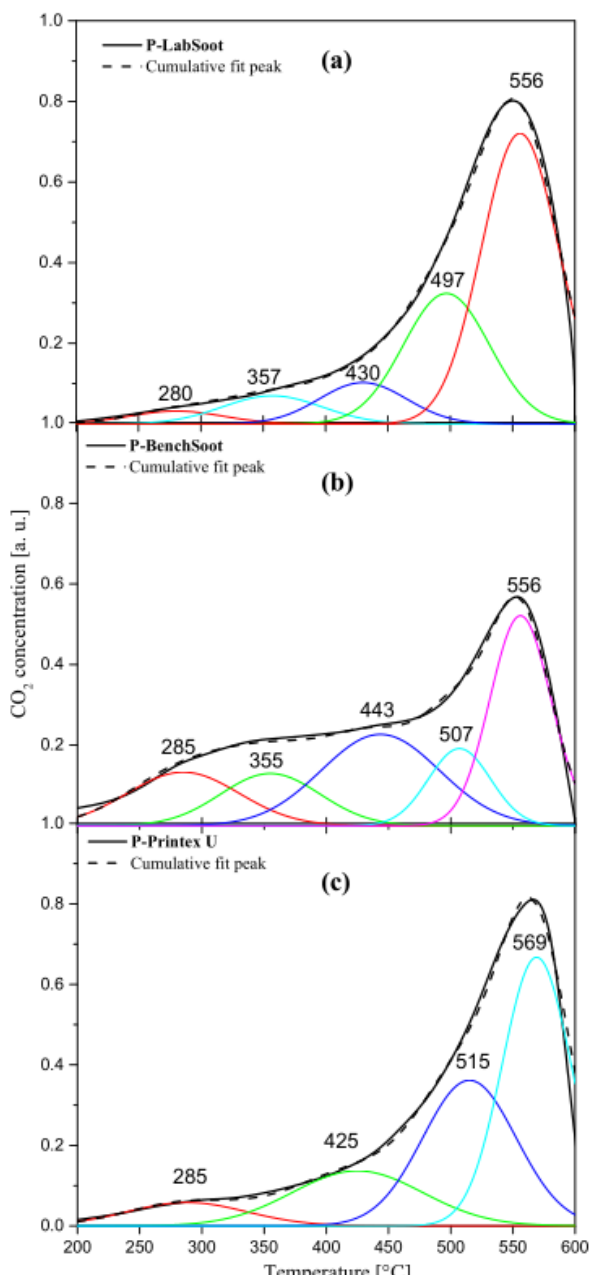
Figure 7. Catalytic activity of ceramic papers without binder (blank tests): ( a ) P-LabSoot, ( b ) P- BenchSoot and ( c ) P-Printex U. Feed composition: 0.1% NO + 18% O 2 balanced in He. The maxima of each deconvolution peak are indicated and the description is shown in Table 4.